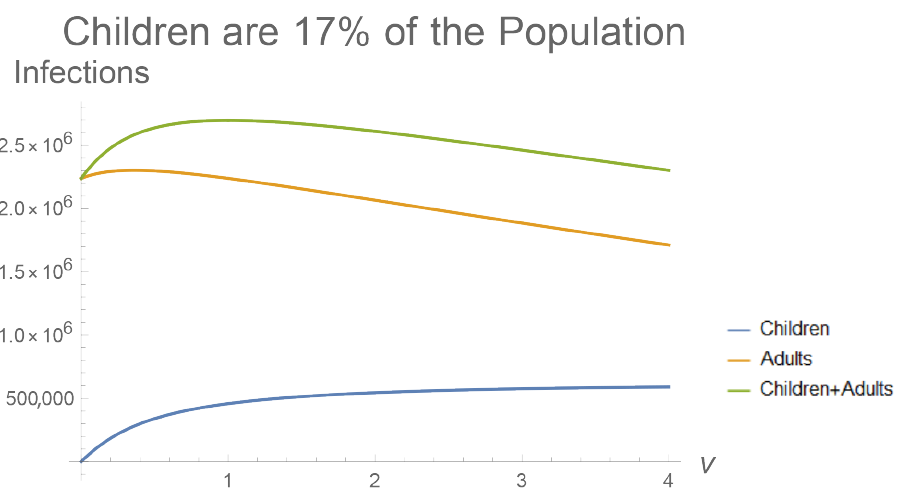
Figure 3. The values of I ∗ a and I ∗ from the age-structured model plotted against ν , the relative k susceptibility of children. Total infections are maximized when children are equally susceptible to adults ( ν = 1). Infections are most concentrated in adults if children are less susceptible ( ν < 1). Children reduce infections in adults if they are more susceptible ( ν > 1). These relationships are more pronounced if children make up a greater share of the population (Figure A2). The population of the United States is N a + N k = 328,239,523, and children are considered under 14 years of age ( N k = 56,406,387)